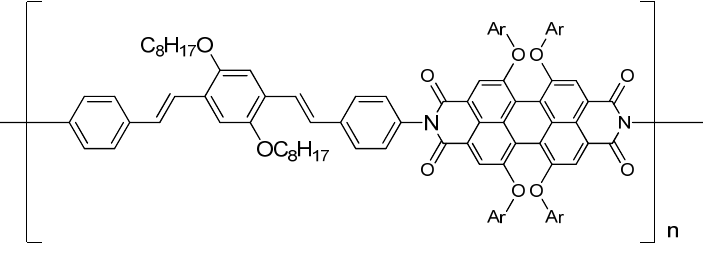
Figure 1. Designed polymer with terphenyldivinyl and perylene